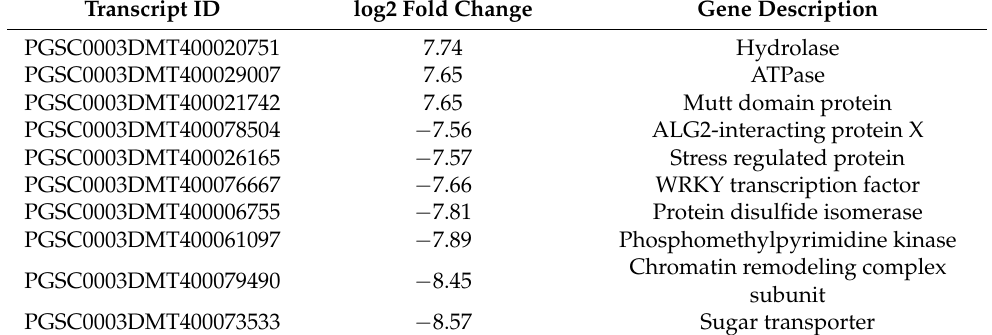
Table 2. Top 10 differentially expressed potato transcripts in A. solani inoculated samples at 1 hpi. Transcript ID, log2 Fold change, and the gene descriptions are displayed.